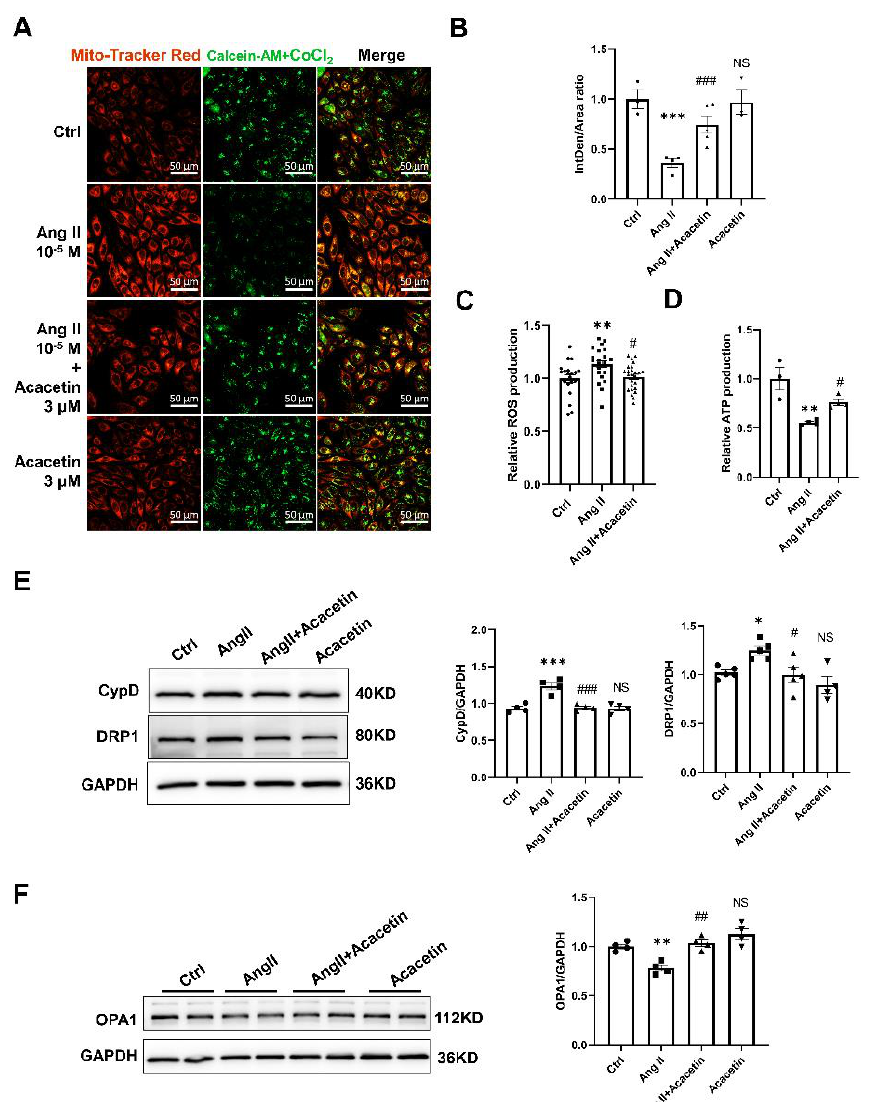
Figure 6. Acacetin inhibited the Ang II mediated mitochondria-dependent apoptosis in HUVECs. ( A ). Representative confocal microscopic images showed that Mitotracker Red confirmed the local- ization of calcein fluorescence in mitochondria. Calcein/CoCl 2 was used to detect the opening of mPTP in different groups (the green fluorescence intensity of calcein decreased when the opening of mPTP was prolonged). ( B ). The bar graph showed the quantification of calcein fluorescence in different groups in the presence of CoCl 2 (*** p < 0.001 vs. Control group; ### p < 0.001 vs. Ang II group; NS indicated p > 0.05 vs. Control group, n = 3 – 5). ( C ). Intracellular ROS was measured by loading the cells with H2DCFDA dye after treatment with compounds as indicated (** p < 0.01 vs. Control group; # p < 0.05 vs. Ang II group, n = 20 – 25). ( D ). ATP was measured by a CellTiter – Glo ® luminescent assay, an indicator of metabolically active cells with normal mitochondria function (** p < 0.05 vs. Control group; # p < 0.05 vs. Ang II group, n = 3). ( E ). Western blot analysis showed the protein expression of CypD and DRP1 in Control, Ang II, Ang II+acacetin and acacetin treated cells. Data were expressed as fold-increase CypD or DRP1 expression normalized to GAPDH. Repre- sentative immunoblots were shown on the left (* p < 0.05 *** p < 0.001 vs. Control group; # p < 0.05 ### p < 0.001 vs. Ang II group; NS indicated p > 0.05 vs. Control group, n = 4 – 5). ( F ). Representative immunoblots and western blot analysis showed the protein expression of OPA1 in control, Ang II treated and Ang II+acacetin treated cells. Data are expressed as fold-increase OPA1 expression nor- malized to GAPDH (** p < 0.01 vs. Control group; ## p < 0.01 vs. Ang II group; NS indicated p > 0.05 vs. control group, n = 4).